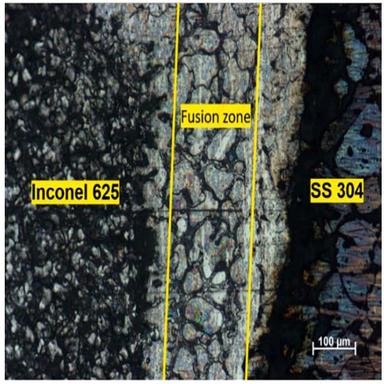
Optical microscope image of joint zone.